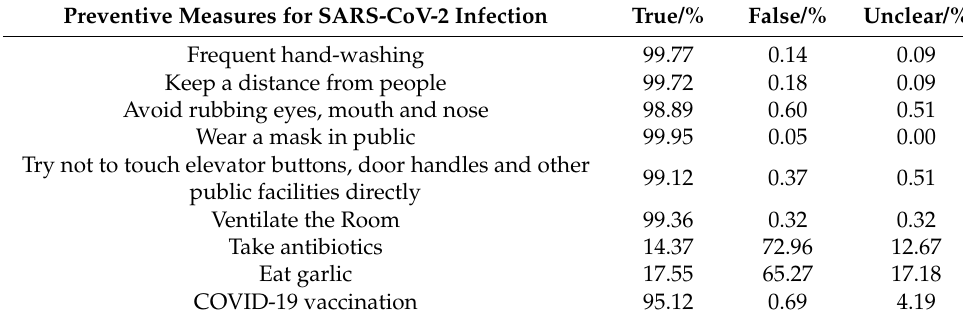
Table 5. Participants’ responses to preventive measures for SARS-CoV-2